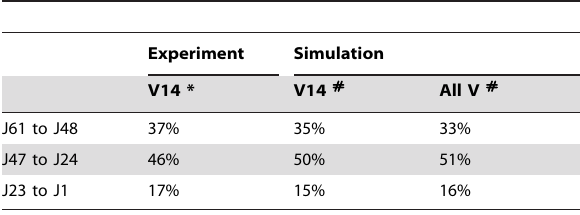
Table 3. J region use by V14: comparison between experimental and simulation data.